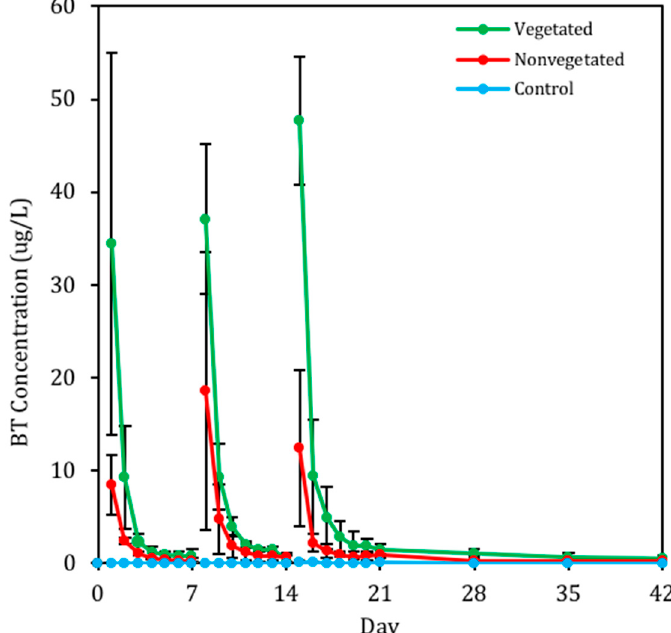
Figure 5. Mean concentration of BT in biofilter mesocosm pore water over the course of the study period (42 days) in the vegetated biofilters (green), nonvegetated biofilters (red), and control biofilters (blue). Storm events occurred on days 0, 7, 14. Error bars represent one standard deviation ( n = 3).